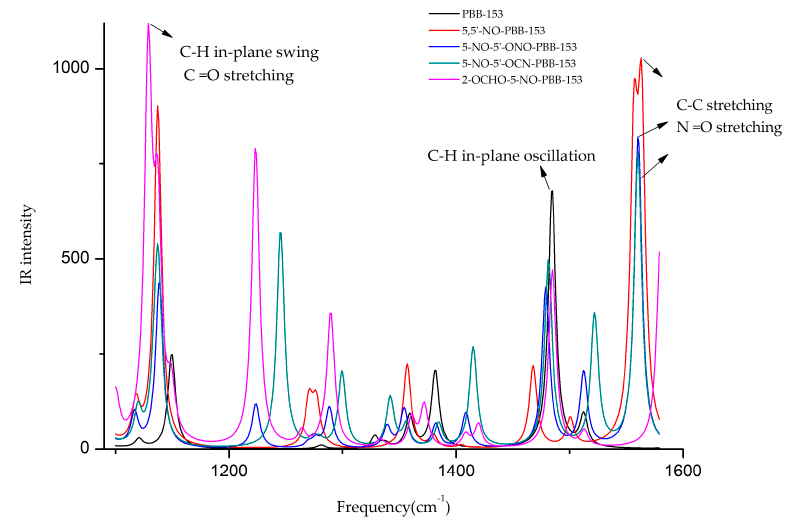
Figure 3. Infrared spectra of different frequencies (1100–1600 cm − 1 ) before and after modification of PBB-153.